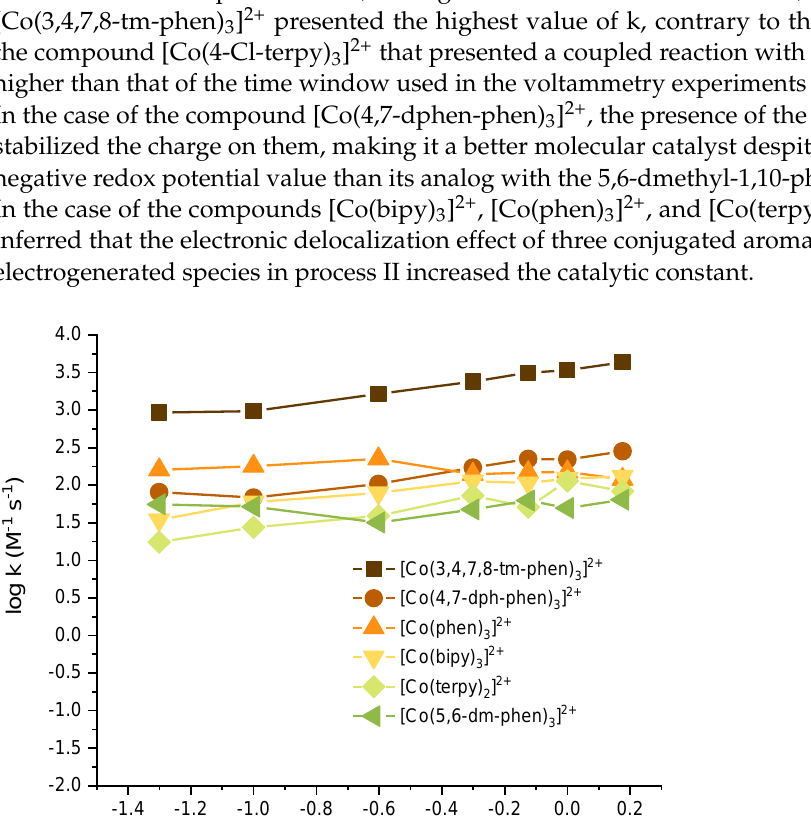
cuit potential to cathodic direction. Glassy carbon disk as a working electrode.